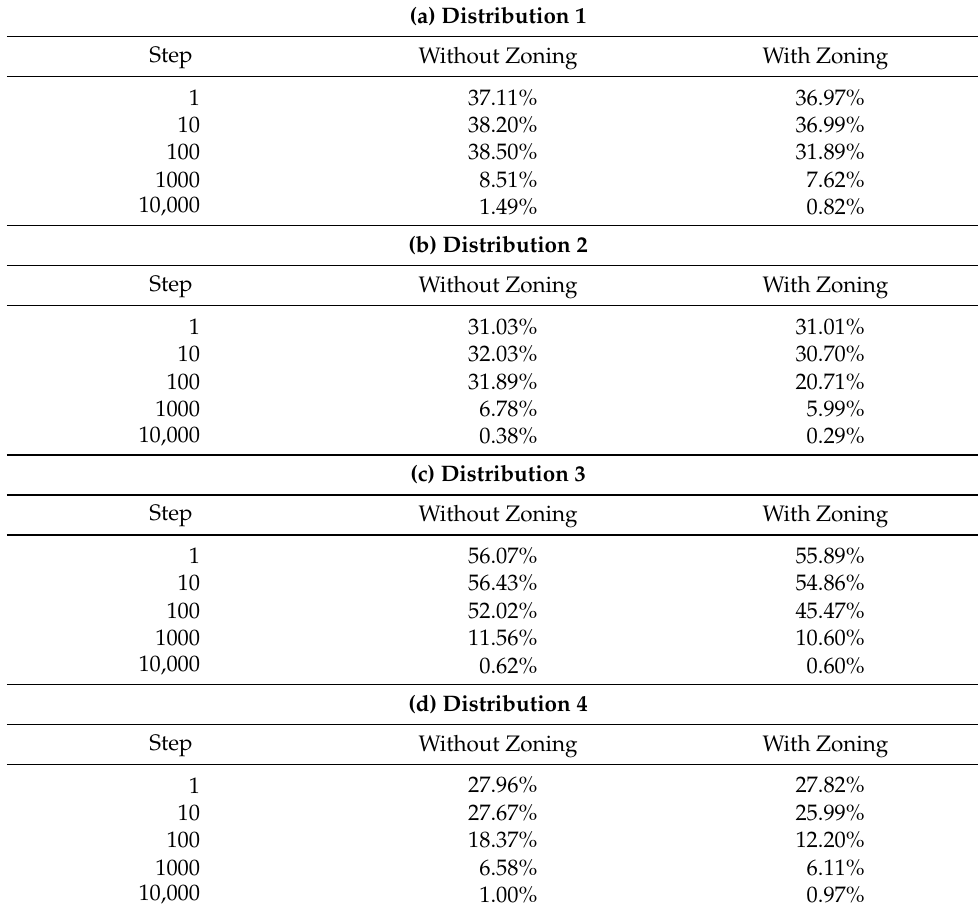
Table 3. Simulation result. Each value represents the mean of infection rate R Mirai for 1000